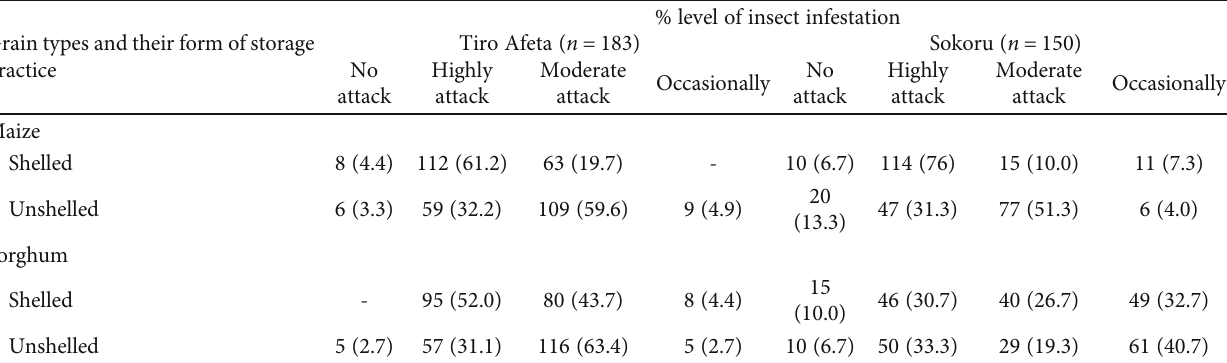
Table 3: Farmers ’ estimation level of insect infestations on stored grain.